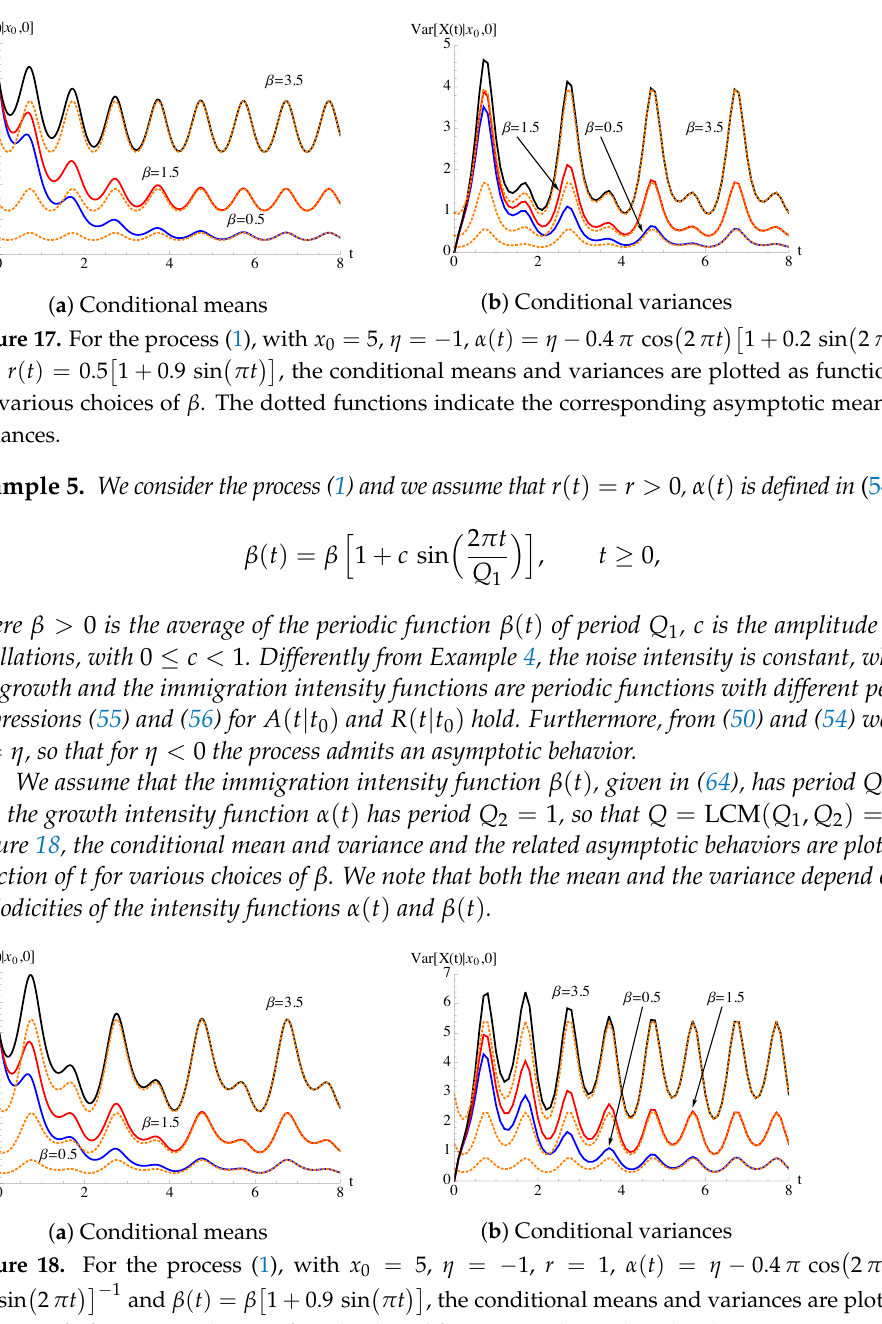
(cid:2) (cid:0) (cid:1)(cid:3) π t 1 + 0.9 sin , the conditional means and variances are plotted as